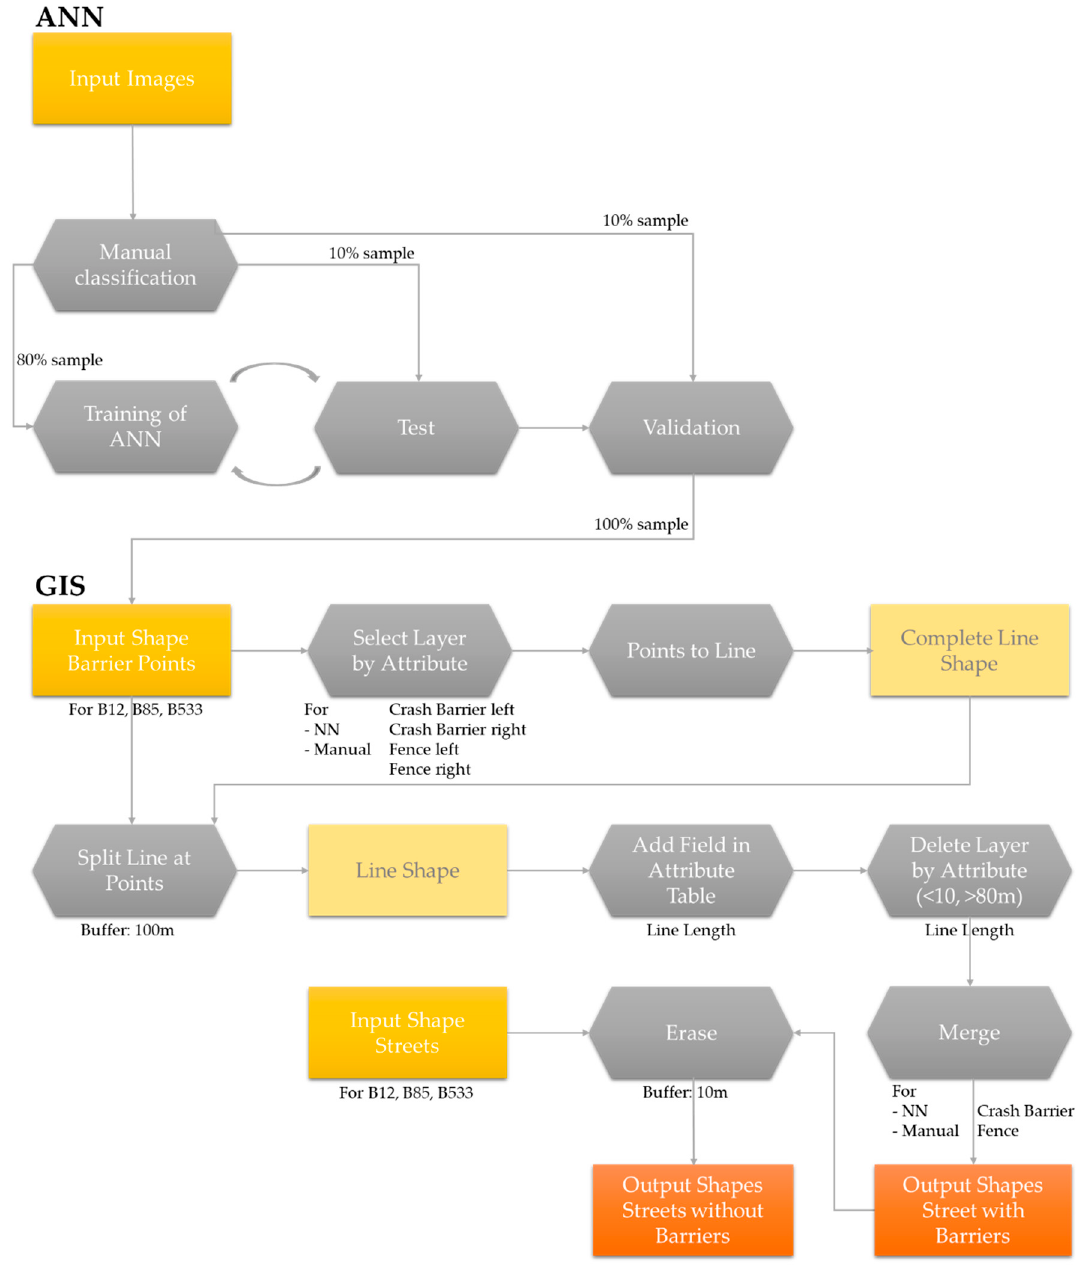
Figure 3. The artificial neural network (ANN) and GIS-based process to build a georeferenced barrier inventory along roads.